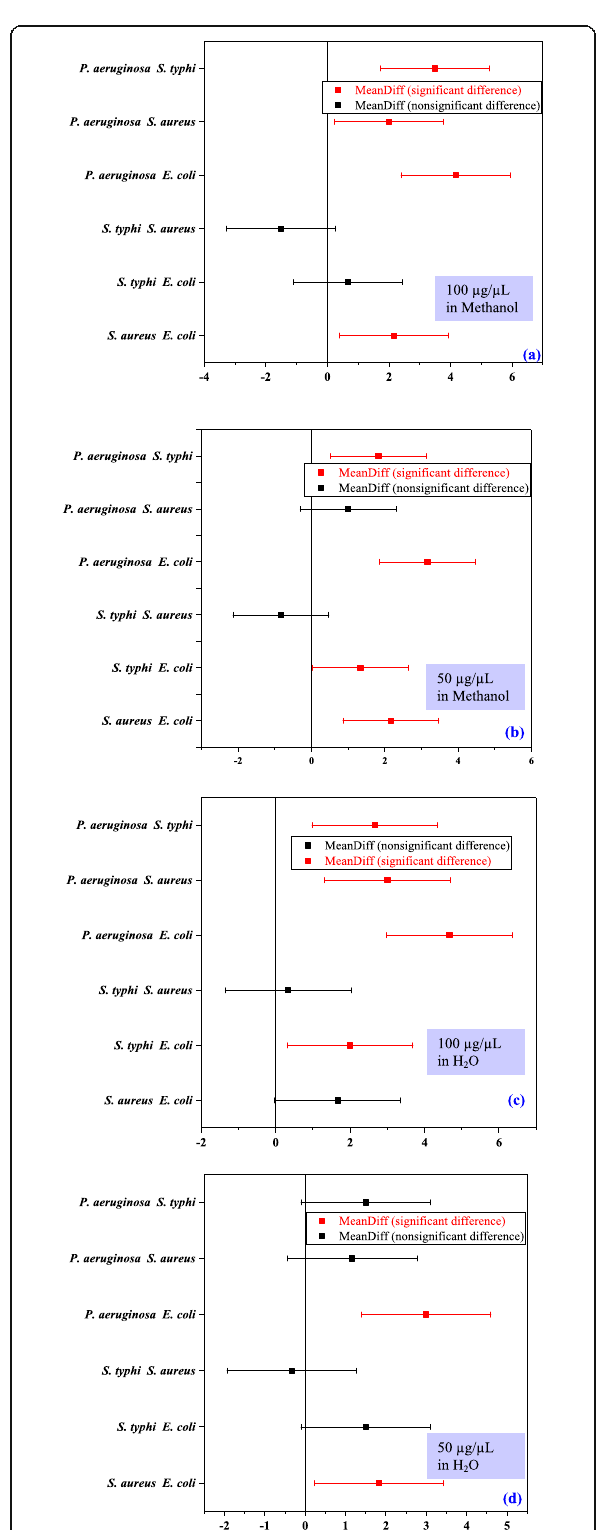
Fig. 5 Mean comparison plot of antibacterial data by Tukey ’ s test for ( a ) 100 μ g/ μ L in Methanol ( b ) 50 μ g/ μ L in Methanol ( c ) 100 μ g/ μ L in H 2 O (d) 50 μ g/ μ L in H 2